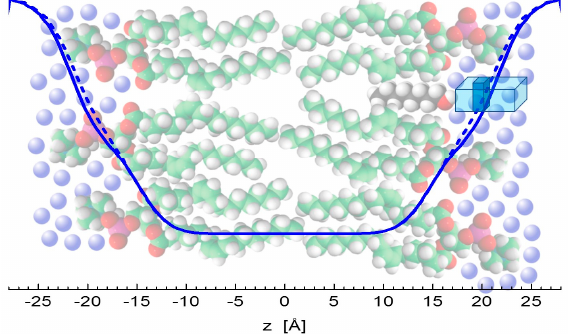
Figure 5. Illustration of water encroachment shown by blue lines. Fewer water molecules penetrate the bilayer composed of neat DOPC (solid line) on the left-hand side, compared to the scenario with alcohol (depicted by black color) intercalating the bilayer on right-hand side (broken line). Water molecules (blue spheres) fill an additional space (the dark portion of a blue rectangle) resulting from increased water penetration and enlarged lateral area above the alcohol molecule.